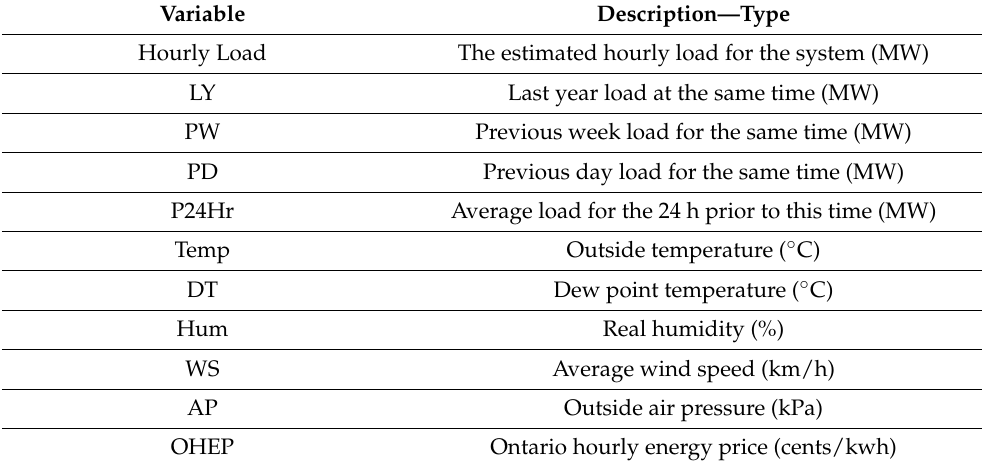
Table 2. Dataset